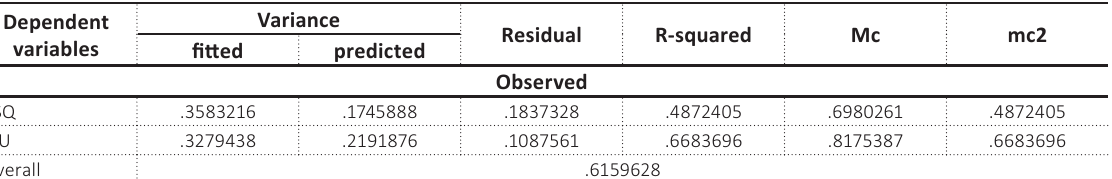
Table 6. Equation-level goodness of